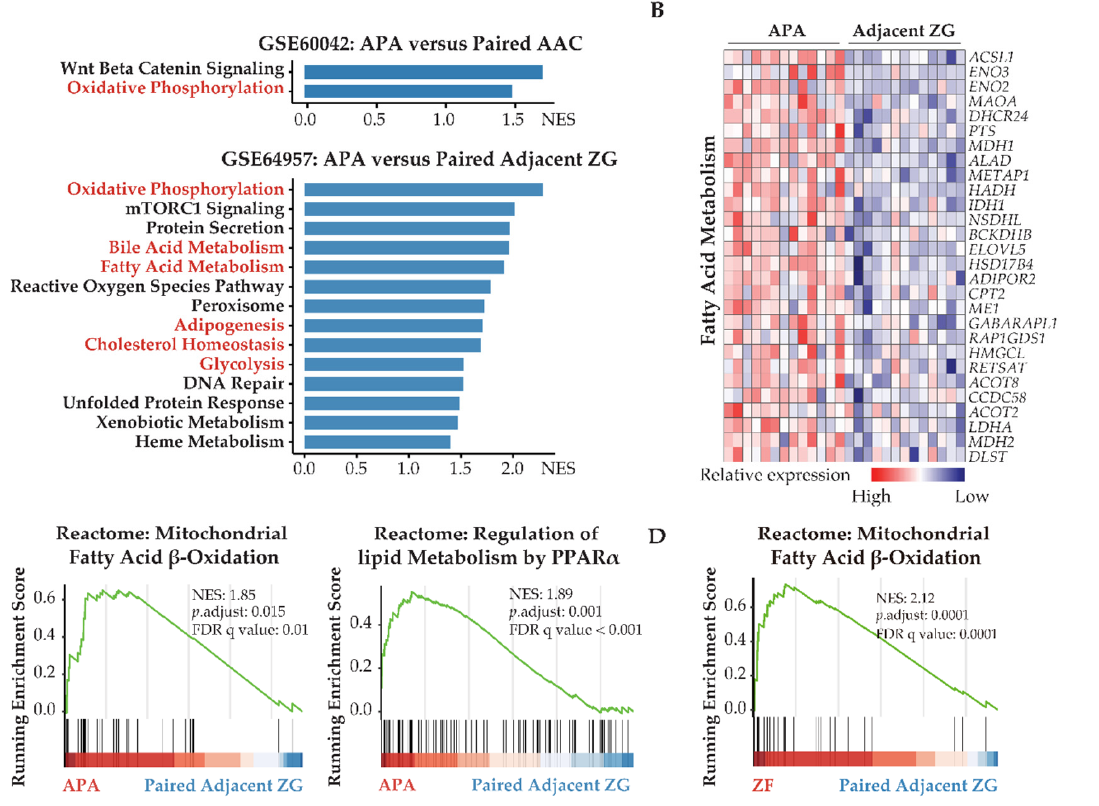
Figure 1. APAs undergo transcriptomic alterations toward increased fatty acid metabolism and glycolysis. ( A ) GSEA showing MSigDB hallmark of upregulated differentially expressed genes in APAs versus AAC (GSE60042) and adjacent ZG (GSE64957). Pathways in red indicate functions related to lipid metabolism and glycolysis. ( B ) Heatmap of the significant upregulated differentially expressed genes with p value < 0.05 for fatty acid metabolism in APAs compared with adjacent ZG. ( C ) GSEA plots showing Reactome pathways of lipid biological processes in APAs versus adjacent ZG. ( D ) GSEA plots showing Reactome pathways of mitochondrial fatty acid β -oxidation in ZF versus paired adjacent ZG. APA, aldosterone-producing adenoma; AAC, adjacent adrenal cortex; ZG, zona glomerulosa; ZF, zona fasciculata; NES, normalized enrichment score; FDR, false discovery rate.